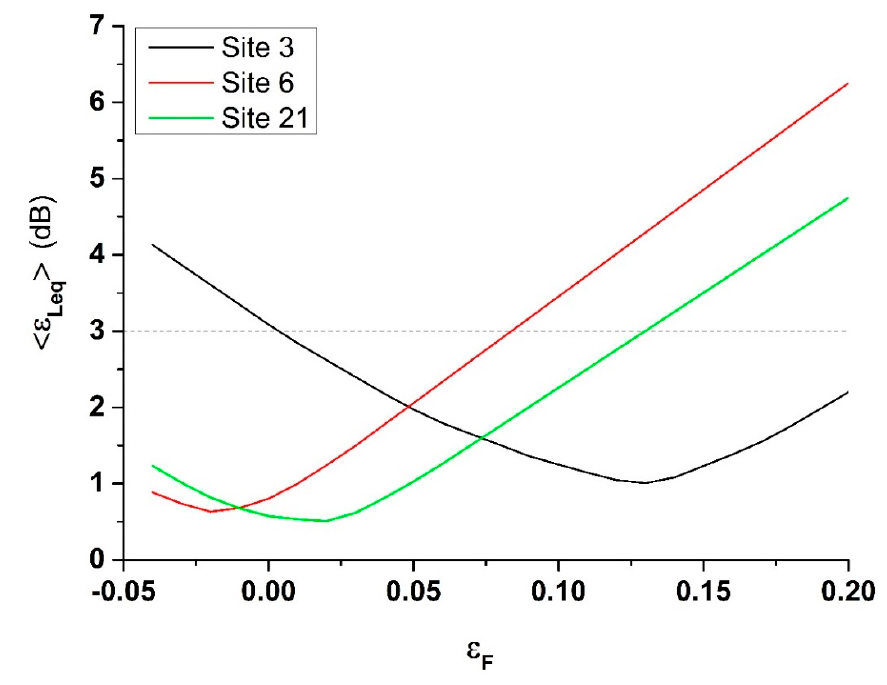
Figure 19. Mean prediction error < ε Leq > as function of the relative traffic flow error (8:00–9:00) ε F for Sites 3, 6, and 21. The graphs have been obtained assuming for simplicity that the relation between ε L and ε F is linear within group g 3 (see Figure 18). The dashed line represents the 3 dB